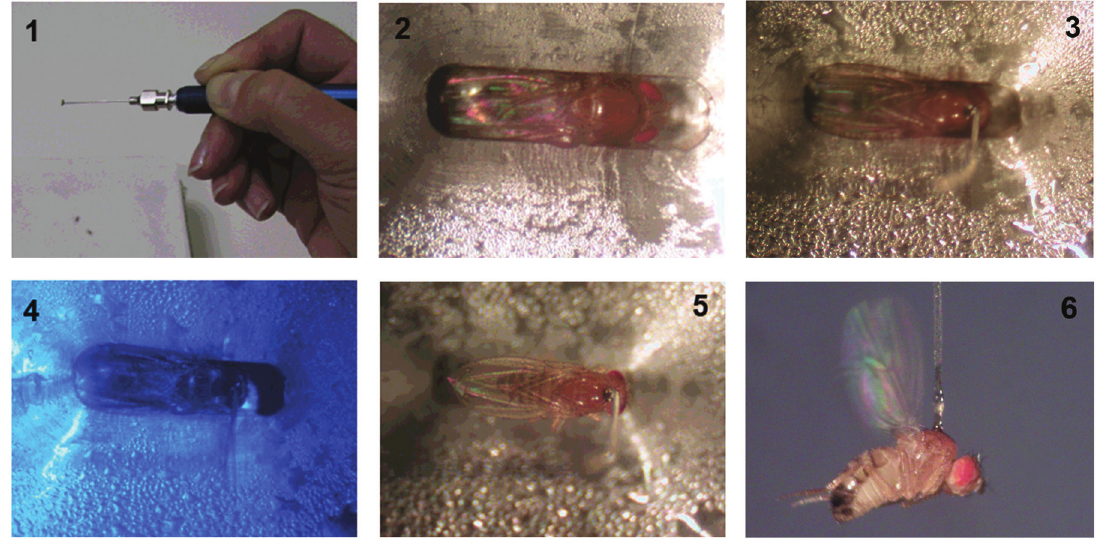
Figure 1 - Tethering a Drosophila for flight: 1) A CO 2 anesthetized fly was selected using vacuum tweezers, 2) positioned in a Peltier cooler at 4 °C which kept it under cold anesthesia, 3) a micropositioner was used to lower a tungsten wire dipped in glass glue onto its thorax, 4) cured with UV for ap- proximately 20 s, 5) removed from the Peltier cooler using the micropositioner, 6) The fly recovered from anesthesia in 3 to 4 min and began flight.